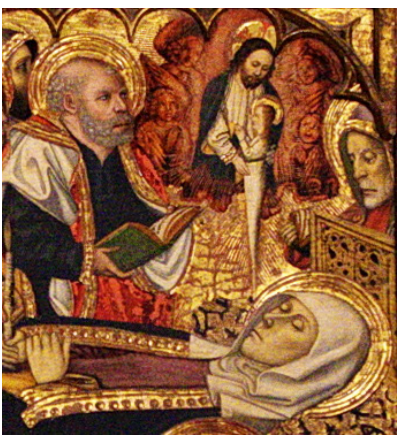
Figure 10. Jaume Huguet, “Dormition”, Altarpiece of the Constable , 1462, Chapel of Saint Agatha, Barcelona.